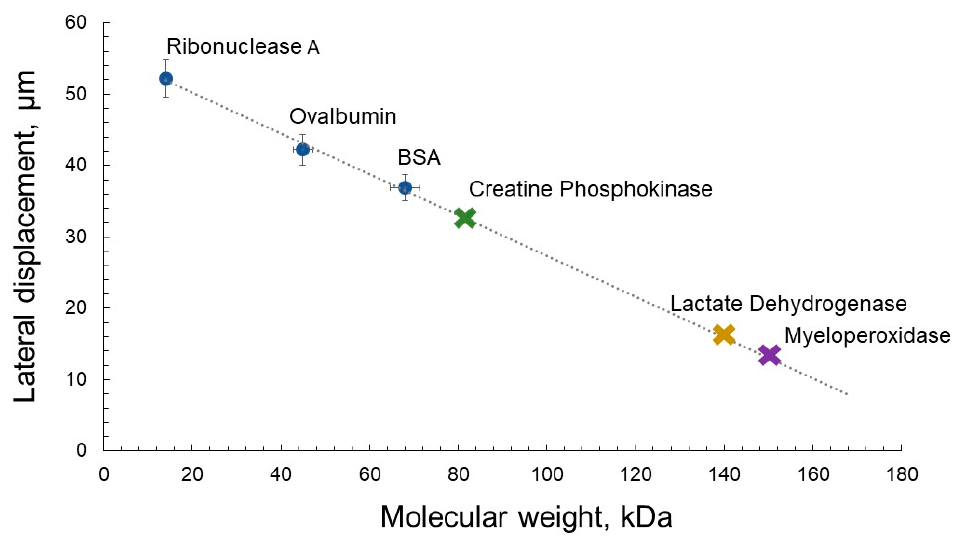
Figure 2. Values of lateral displacement of protein particles depending on the molecular weight of globular proteins.